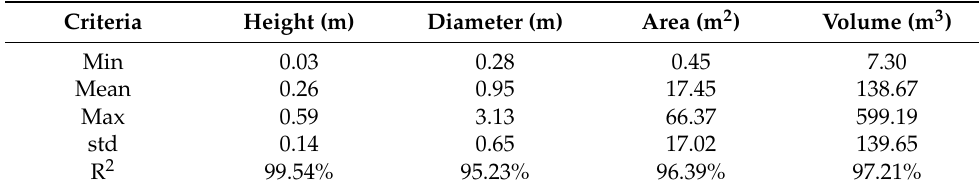
Table 3. The difference between estimated tree canopy parameters using photogrammetric and LiDAR point clouds.